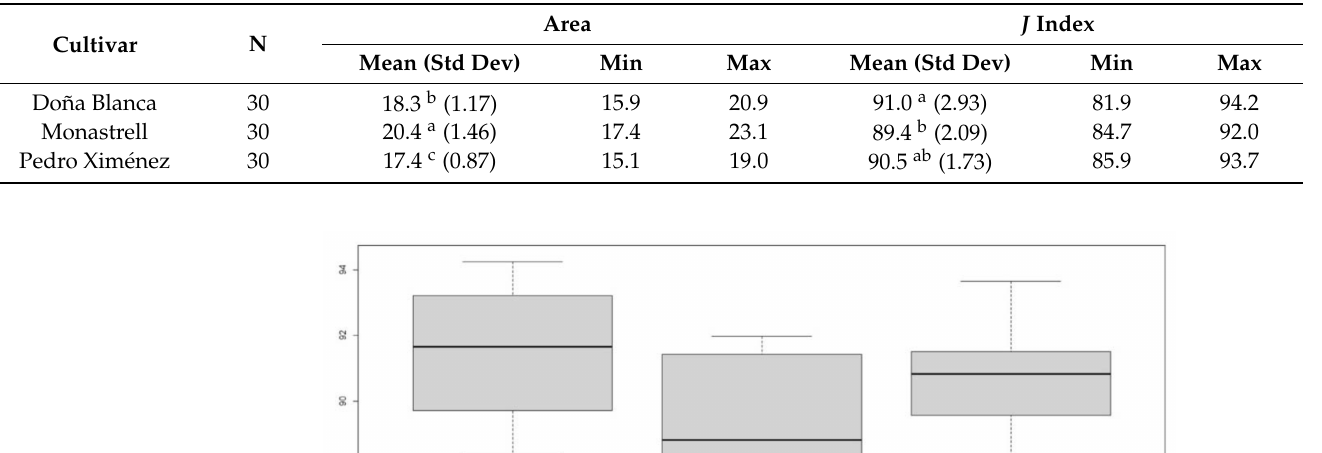
Figure 18. From left to right: A sum of the silhouettes of 30 seeds, a silhouette obtained by the pixel profile of the first image, the Doña Blanca model, and four representative seeds of Doña Blanca. Bar represents 1 cm. Table 10. Values of area and J index in the cultivars of the Doña Blanca group. Superscript letters indicate the results of Tukey test: the mean values marked with the same letter in the superindex of each column do not differ significantly at p < 0.05. N is the number of seeds analyzed.